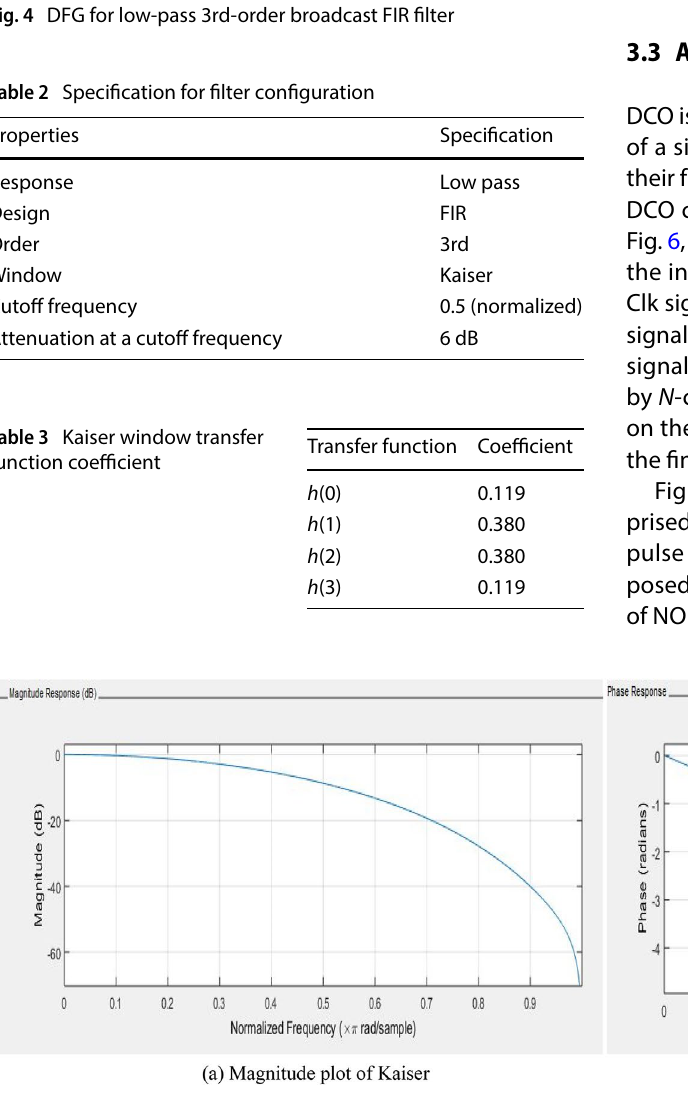
Fig. 5 a Magnitude plot of Kaiser. b Phase plot of